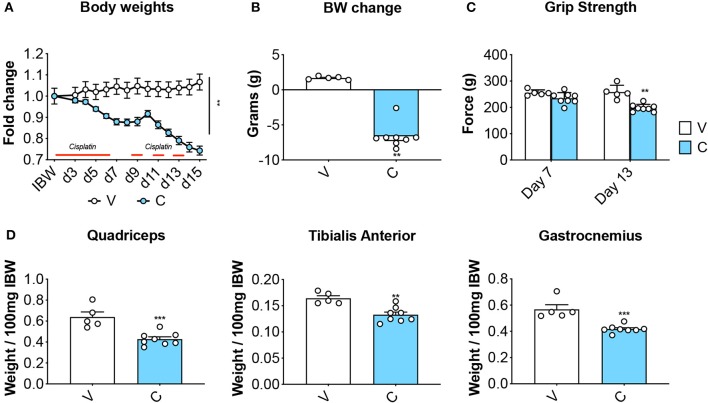
Cisplatin causes body weight loss and muscle depletion. Body weight curves (A), body weight change (i.e., body weight at time of sacrifice vs. initial body weight) (B), whole body grip strength (reported as peak force measured at day 7 and day 13) (C) and skeletal muscle weights (D) in mice exposed to cisplatin (n = 8). Control animals (V; n = 5) were administered equal volumes of sterile saline. Muscle weights were normalized to the Initial Body Weight (IBW) and expressed as weight/100 mg IBW. Data (means ± SEM) are expressed in grams. Significance of the differences: **p < 0.01, ***p < 0.001 vs. V.